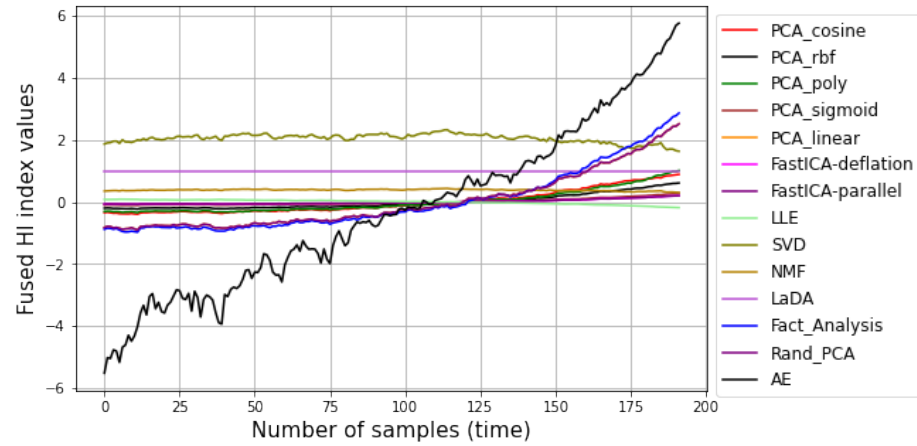
Figure 5. HI construction output of Fusion Algorithms.